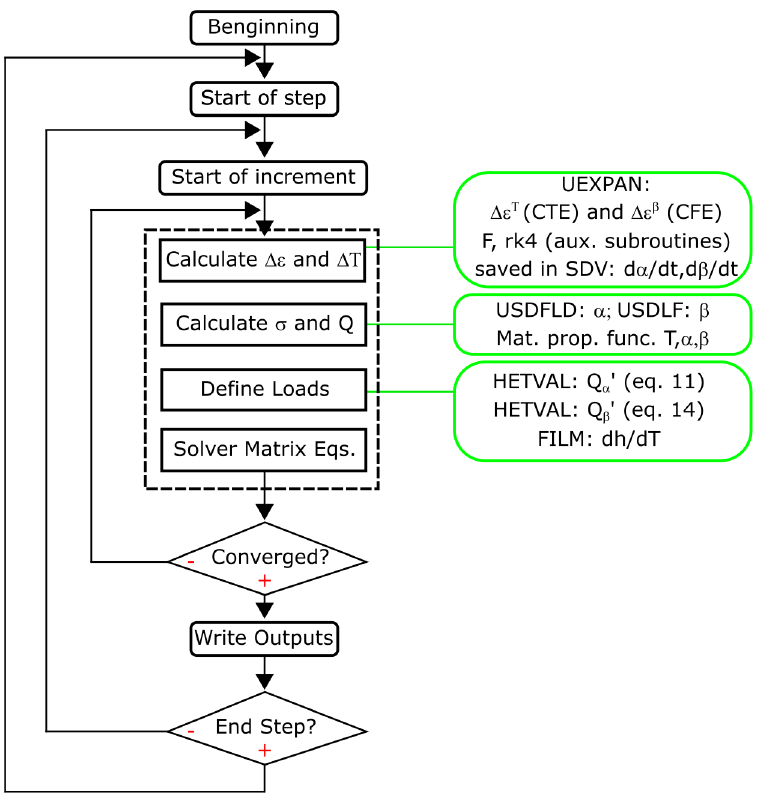
kinetics Figure 3. Fully-coupled algorithm of thermal-mechanical simulation with subroutines for kinetics coupling.